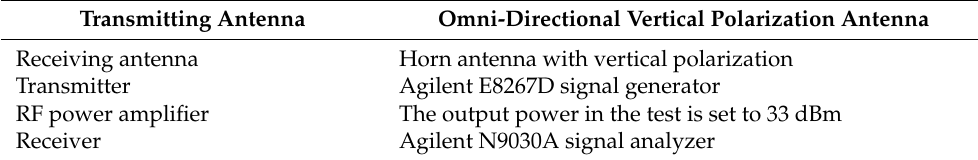
Table 2. The antenna setup features.